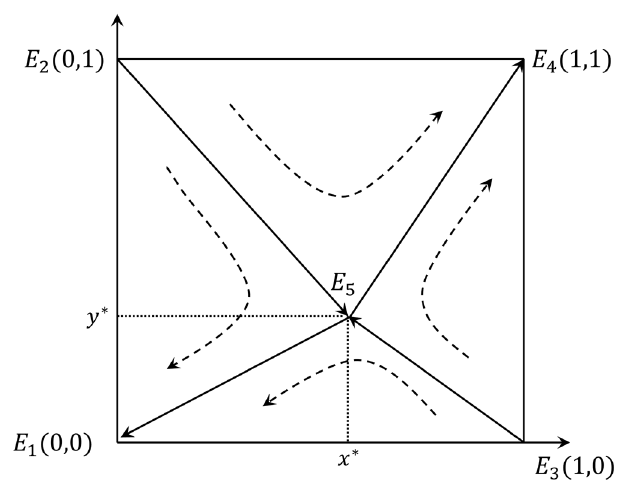
Figure 5. Dynamics evolution schematic diagram of the SME and the LF.